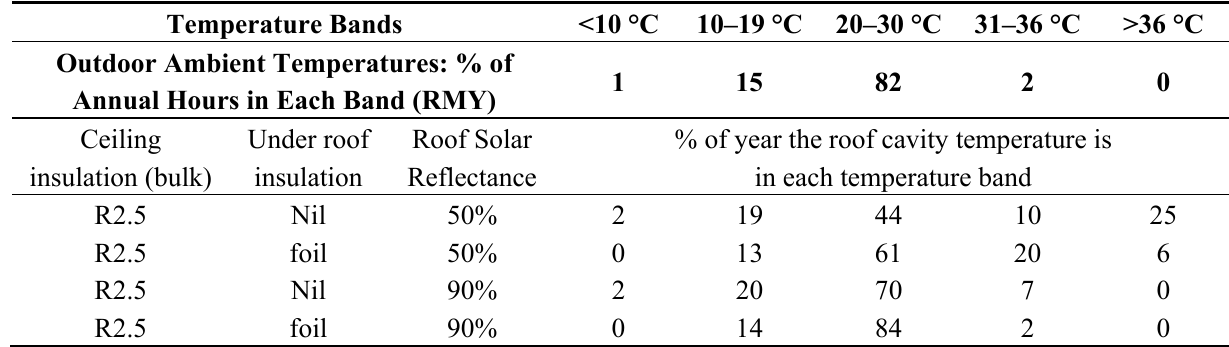
Table 7. Effect of roof insulation and roof reflectance on roof cavity temperature. Temperature Bands <10 °C 10–19 °C >36